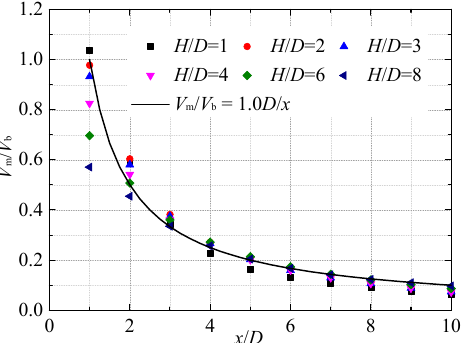
Figure 13. Variation of normalized maximum velocity V m /V b along the x direction.